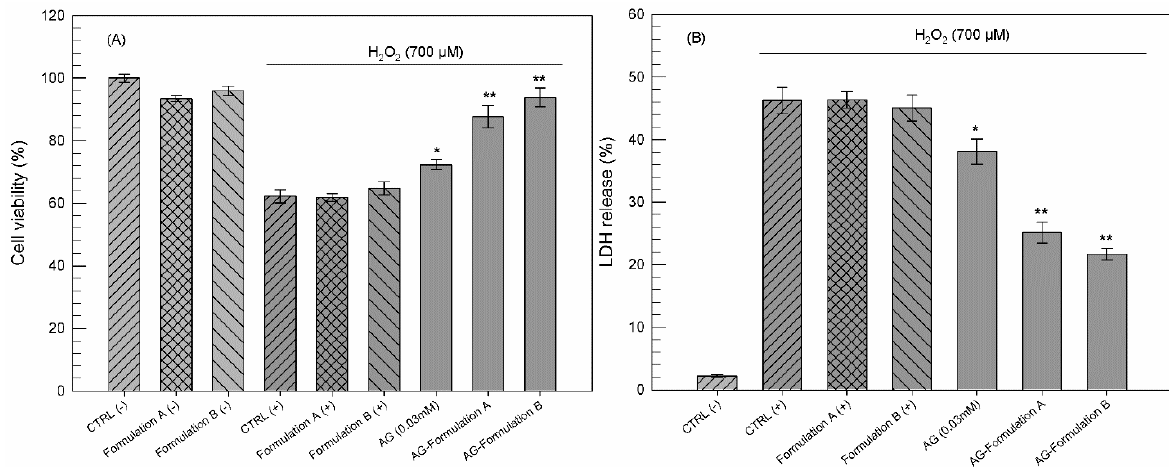
Figure 3. Antioxidant activity of ammonium glycyrrhizinate in free form and loaded in unsaturated fatty acid vesicles, expressed as NCTC 2544 viability ( A ) and lactic hydrogenase (LDH) release ( B ). Cells were treated with ammonium glycyrrhizinate (0.03 mM), alone or loaded in the vesicles for 24 h and then with H 2 O 2 (700 µ M) for 2 h. Results are expressed as mean values of three different experiments from three different batches ± standard deviation. If bars are not visible, they are within the symbol. * p < 0.05 and ** p < 0.001 versus H 2 O 2 positive control (CTRL (+)). (AG = ammonium glycyrrhizinate).